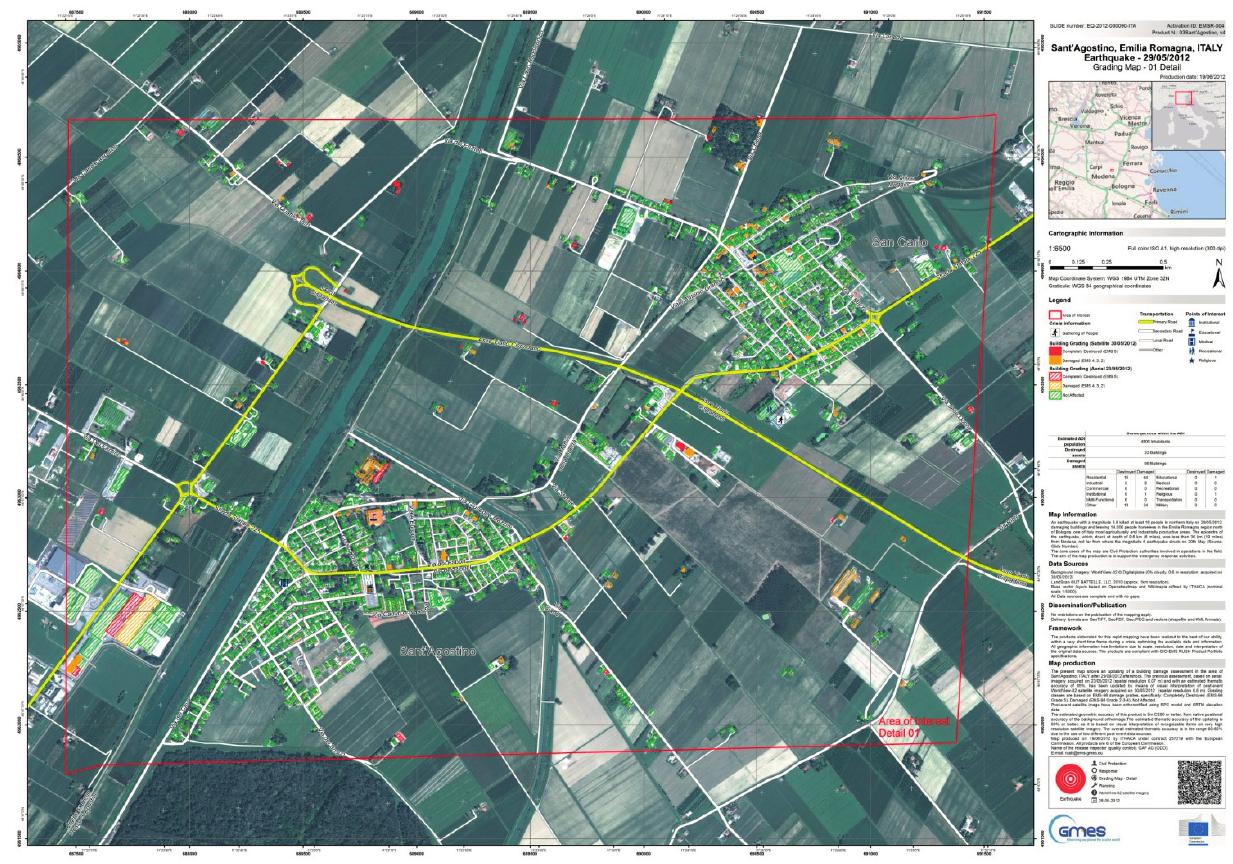
Figure 12. Example of post-event damage assessment map based on both aerial and satellite imagery (Copernicus Emergency Management Service–Mapping